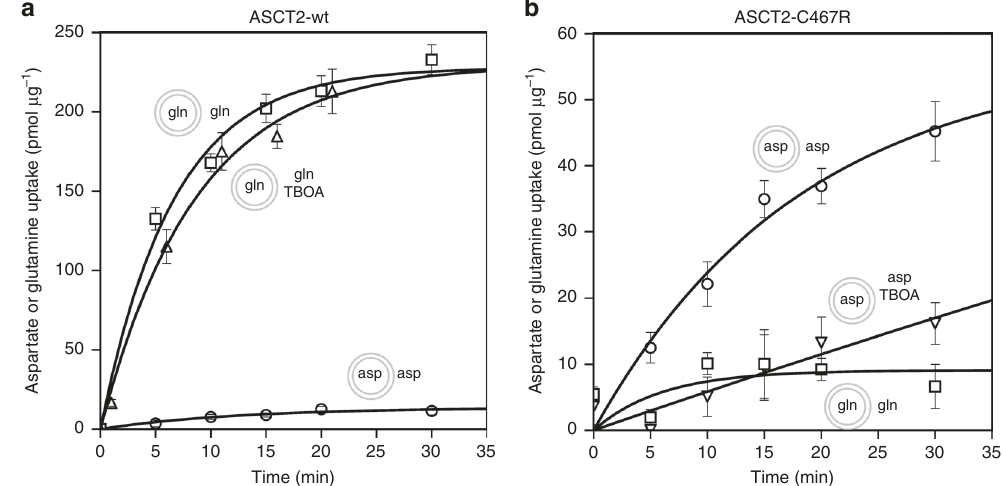
Fig. 1 Transport activity of reconstituted puri fi ed ASCT2 wt ( a ) and ASCT2 C467R ( b ). Curves show the counter fl ow of external radioactively-labelled and internal unlabelled L -glutamine (squares, n = 6 for ASCT2 wt, n = 3 for ASCT2 C467R ); counter fl ow of L -glutamine in presence of 0.6 mM DL-TBOA (upward triangle, n = 4); counter fl ow of L -aspartate (circles, n = 3 for ASCT2 wt, n = 5 for ASCT2 C467R ); and counter fl ow of L -aspartate in presence of 0.5 mM DL- TBOA (downward triangles, n = 3). Data points and error bars represent means and s.e.m. from n biologically independent experiments. Small schemes depict proteoliposomes with internal and external compound compositions used in respective experiments. Source data are provided as a Source Data fi